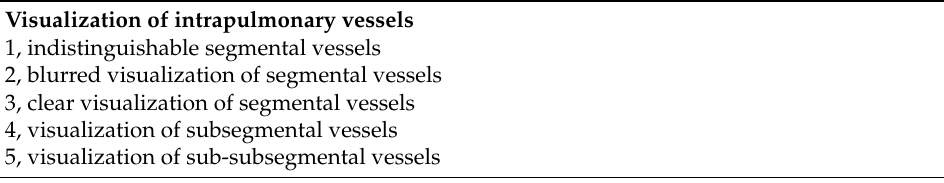
Table 1. Qualitative scoring system of ZTE lung MR